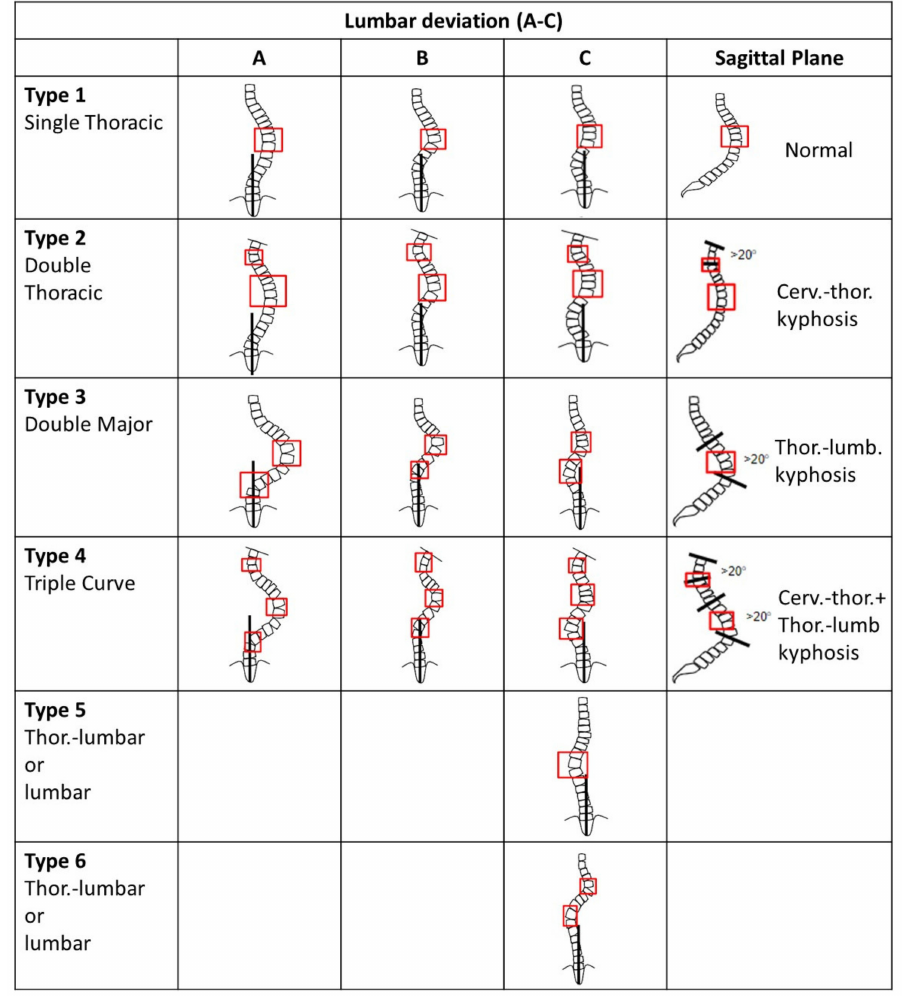
Figure 1. Lenke classification for spinal curvature. Modified from [6]. Generally, Type A has the CSVL between the pedicles to the lumbar apex. Type B has the CSVL touching the apical bodies to the lumbar apex. Type C has the CSVL completely medial to the apical lumbar